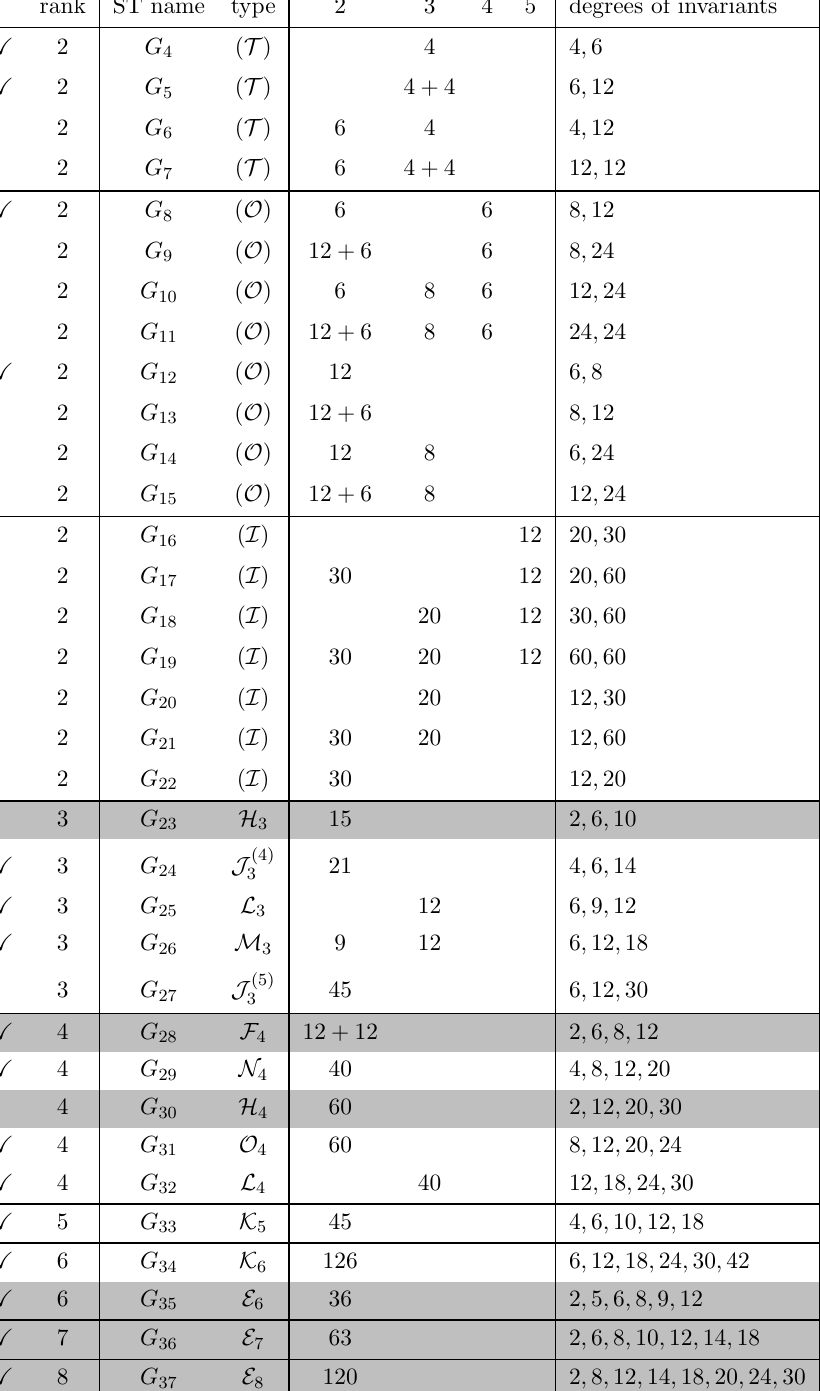
Table 2 . Data of exceptional complex reflection groups. The columns are for the Shephard-Todd name, the corresponding subgroup of SO(3) when rank = 2 or the corresponding line system when rank 3, the number of pseudoreflections in each order (where + denotes the existence of more ≥ than one conjugacy classes), and the degrees of invariants. Real reflection groups are shaded, and the ones with X are